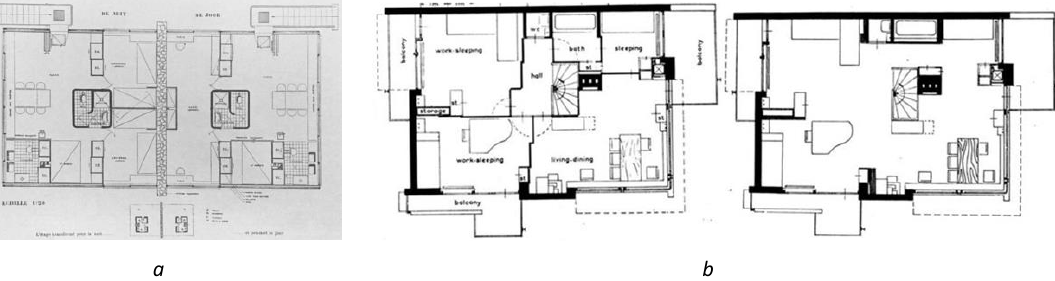
Figure 2 Flexible use arrangements with movable parts, a) Loi Loucheur, Le Corbusier, 1928 (Benton, 1984), b) Schröder House, G. Rietveld, 1924